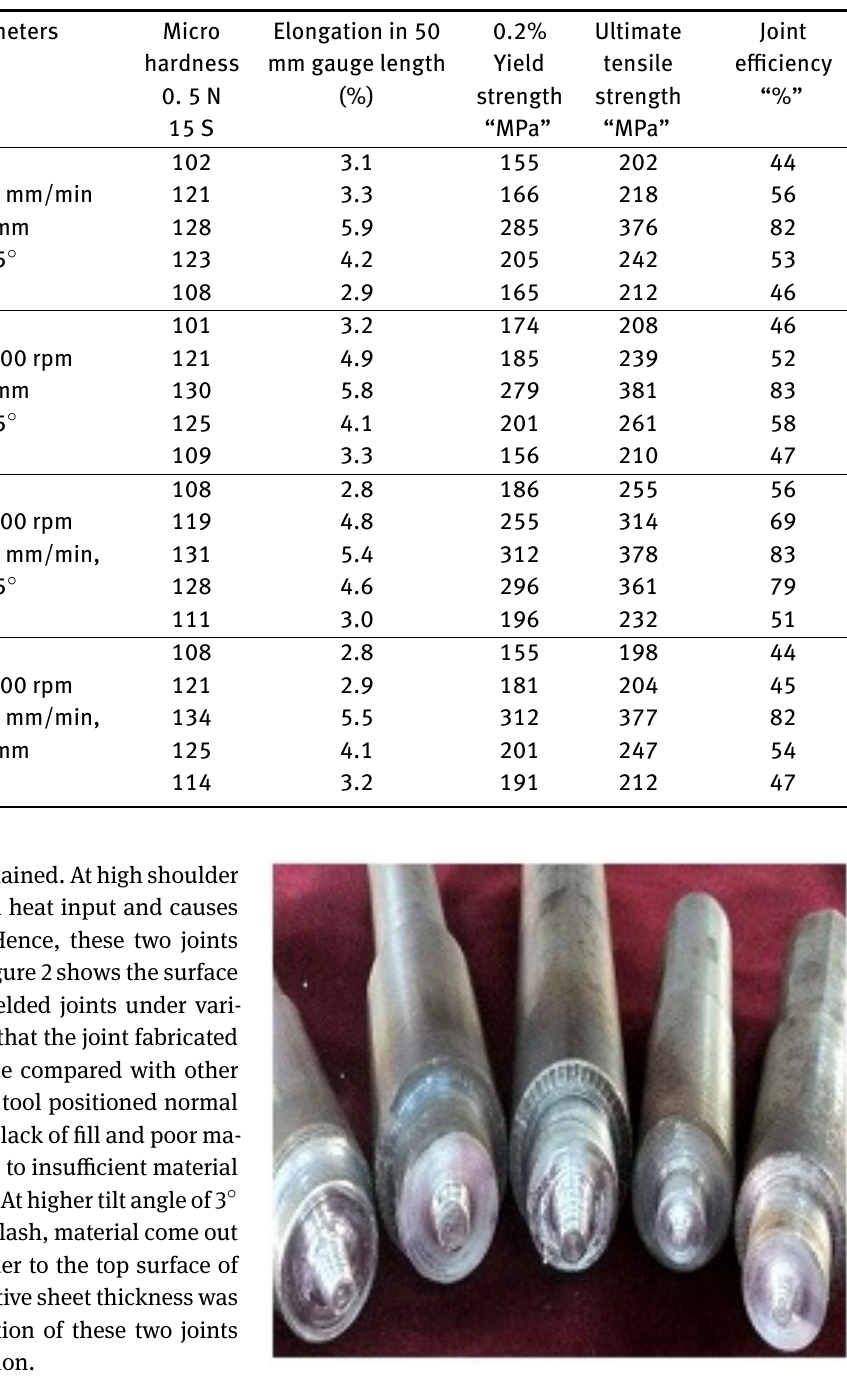
Figure 3: Photograph of fabricated